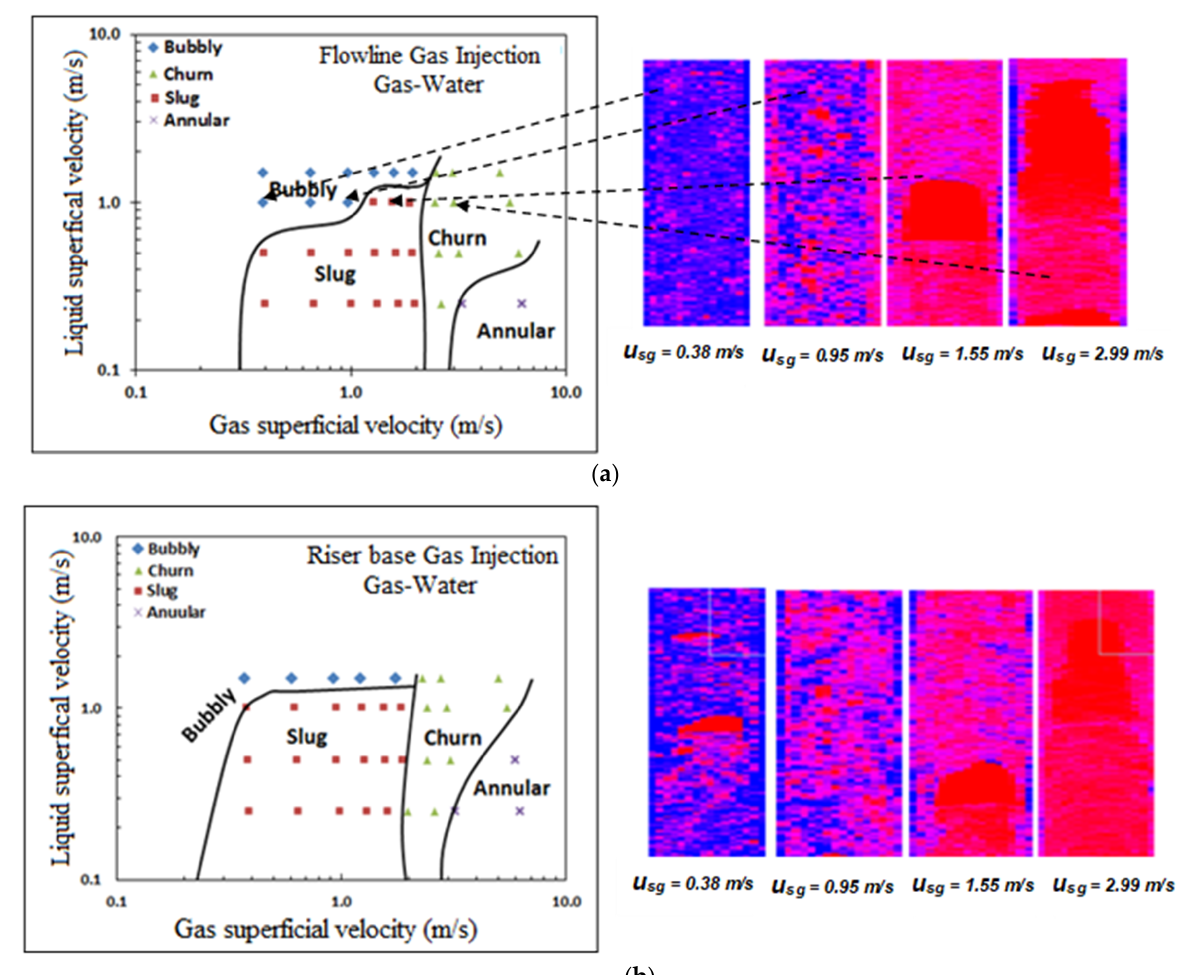
Figure 4. Flow regime map for air-water flow at top of the riser, ( a ) flowline and ( b ) riser base gas injection. All reconstructed images on the right are for 𝑢 (cid:3046)(cid:3039) = 1.0 m/s .